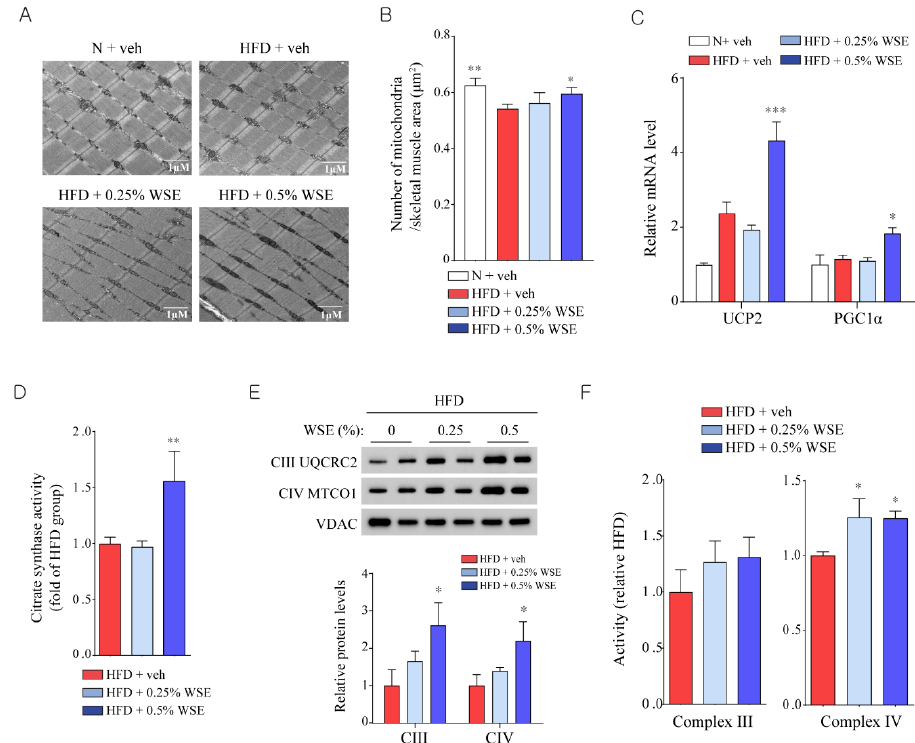
Figure 3. WSE improves mitochondrial function in skeletal muscle. ( A ) Representative transmission electron microscopic images of the skeletal muscle. ( B ) Number of mitochondria per skeletal muscle area. ( C ) Relative mRNA levels of mitochondrial-related genes in skeletal muscle. ( D ) Citrate synthase activity in skeletal muscle. ( E ) Expression of protein involved in mitochondrial complexes III and IV in skeletal muscle, and densitometry-based quantification of the data, normalized to the level of VDAC ( n = 3). ( F ) Activity of mitochondrial complexes III and IV in skeletal muscle. Data represent the mean ± SEM ( n = 5). Di ff erence between groups was evaluated by Tukey’s multiple comparison test. * p < 0.05; ** p < 0.01; *** p < 0.001 compared with the HFD